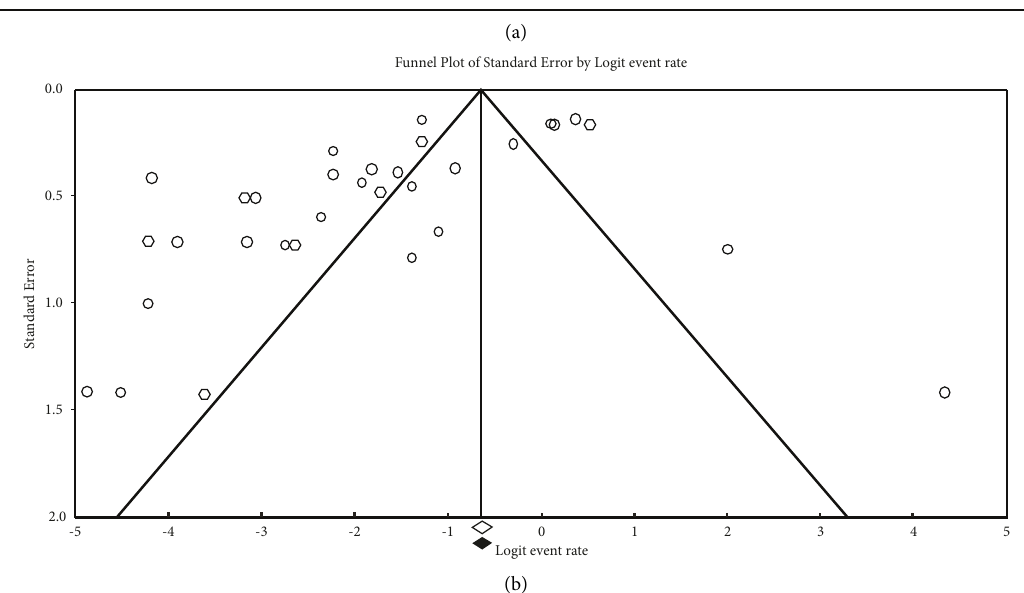
Figure 2: Forest plots (a) and funnel plots (b) illustrate the prevalence of imipenem-resistant Enterobacter species in